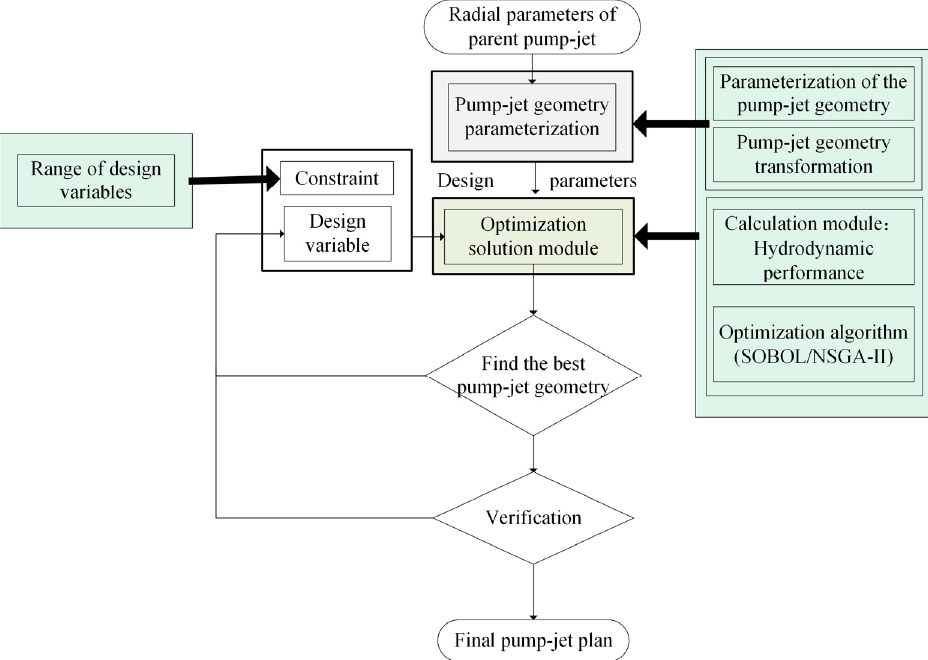
Figure 14. Optimization design procedure chart of pump-jet propulsion system.